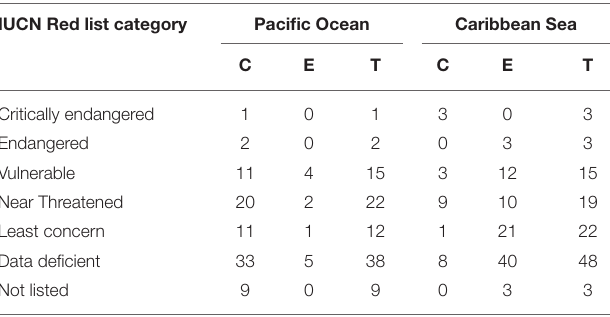
TABLE 2 | Conservation status of Costa Rican